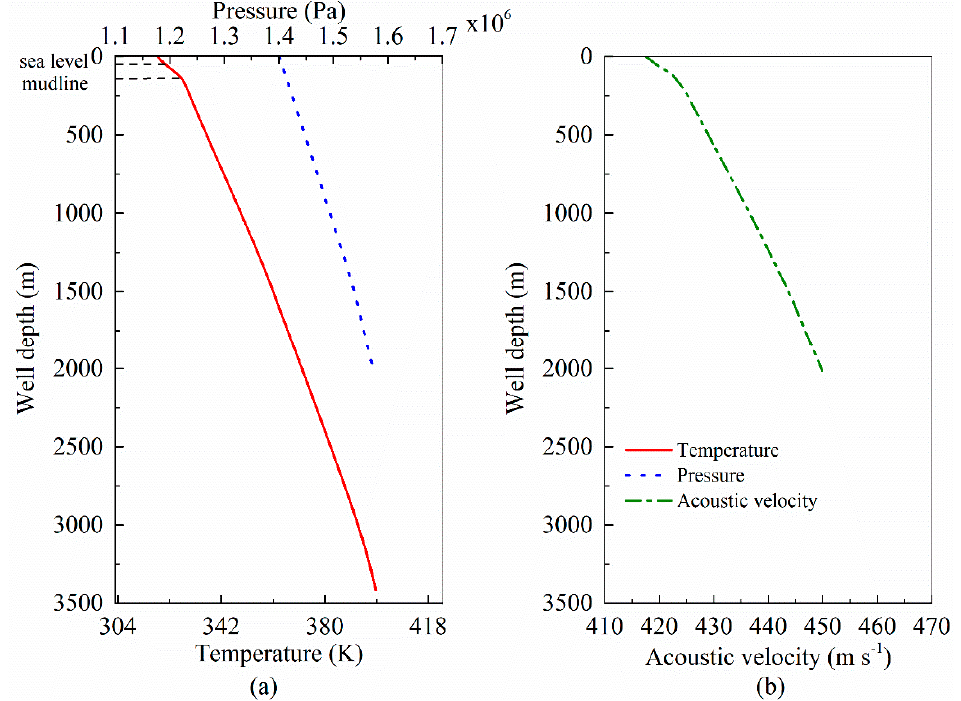
Figure 19. Calculating profiles in the annulus: ( a ) Temperature and pressure, and ( b ) acoustic velocity.